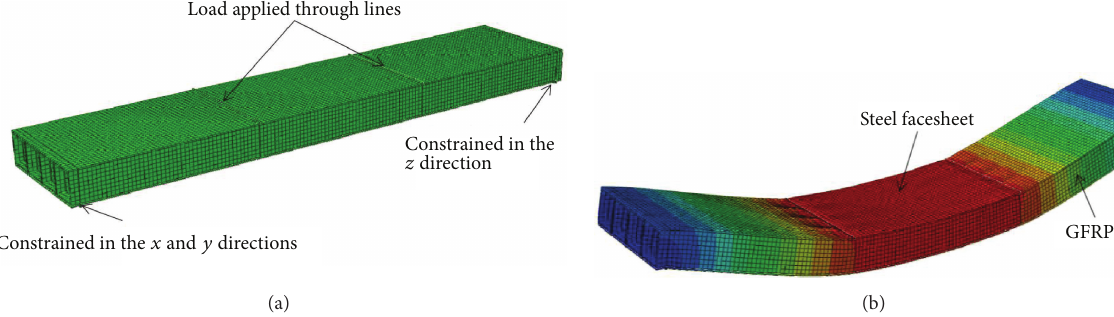
Figure 16: Finite element model for the sandwich panel specimen: (a) meshing and loading setup and (b) deformed shape.